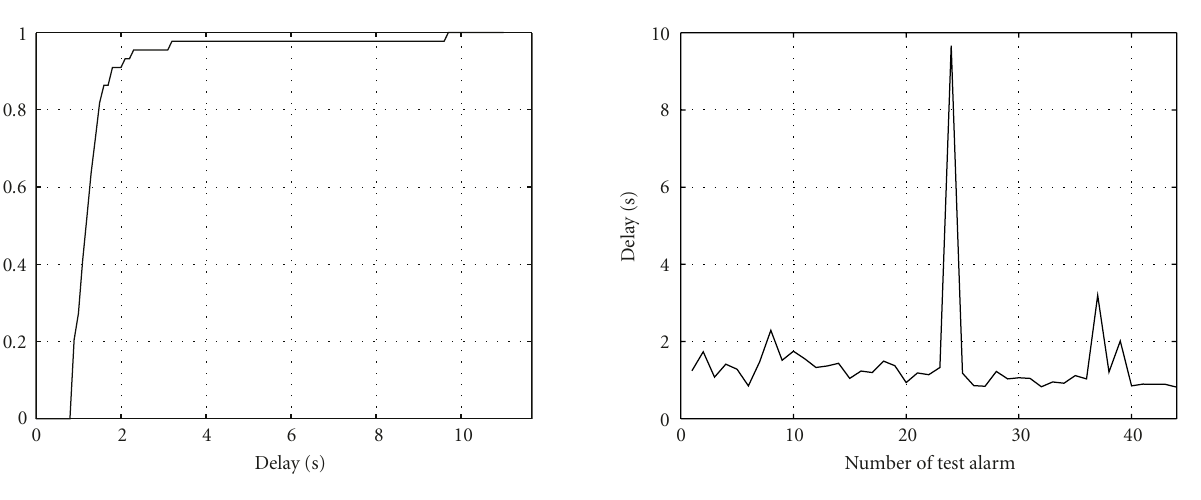
power source is between 3 and 26 months with the used access cycle values. The mobile node lifetime does not double when the access cycle is doubled, because the sleep mode power consumption of the mobile node is not